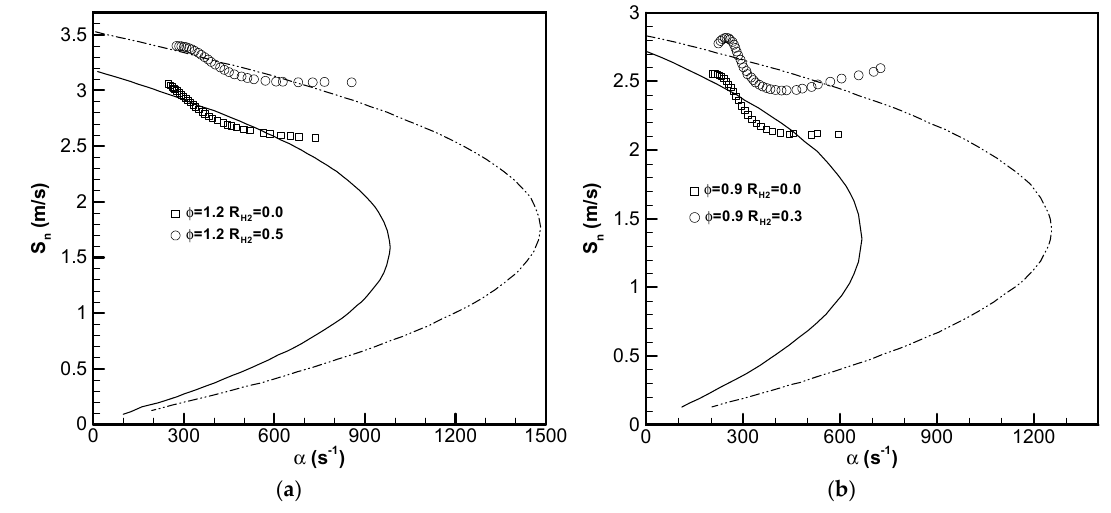
Figure 6. Effect of hydrogen addition on S n versus flame stretch. ( a ) T = 390 K; ( b ) T = 420 K.